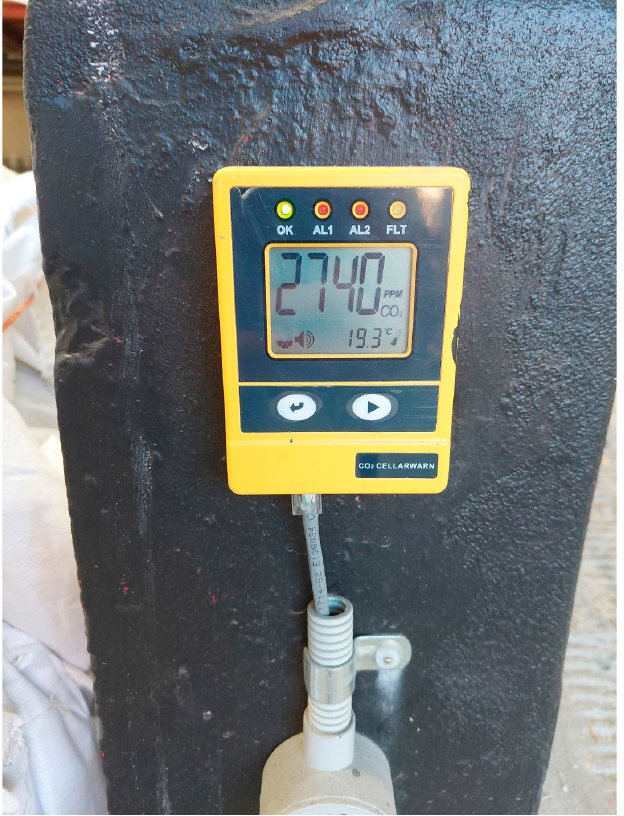
Figure 1. An example of a hard-wired CO 2 monitoring system used in an Australian brewery.